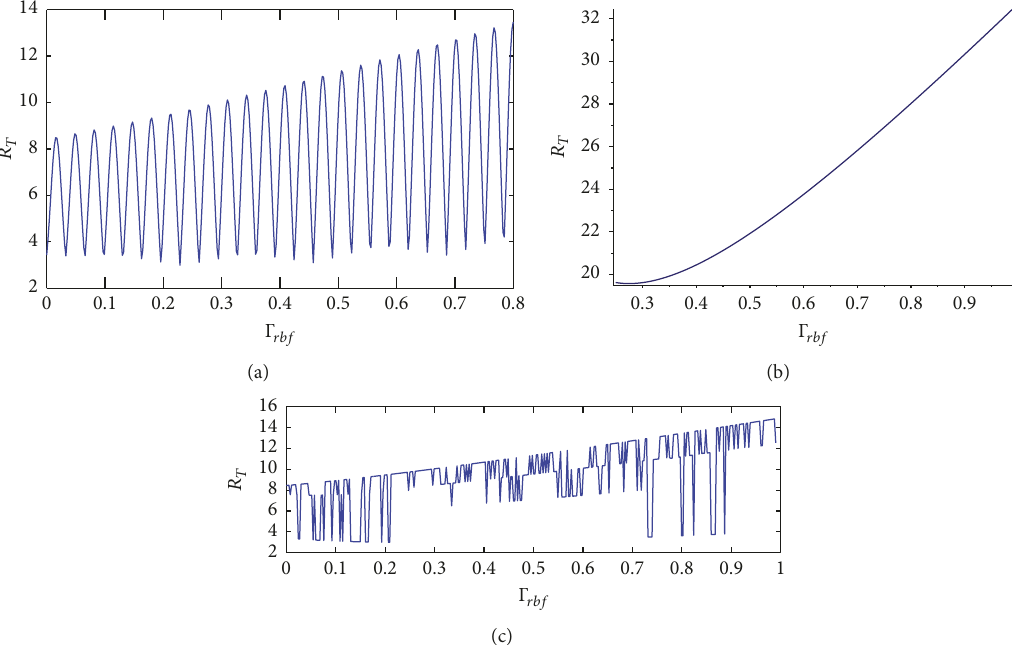
Figure 10: The effect of increased infection rate to fleas from the infectious rodents ( 𝐼 𝑅𝐵 ) on the periodic reproduction number.